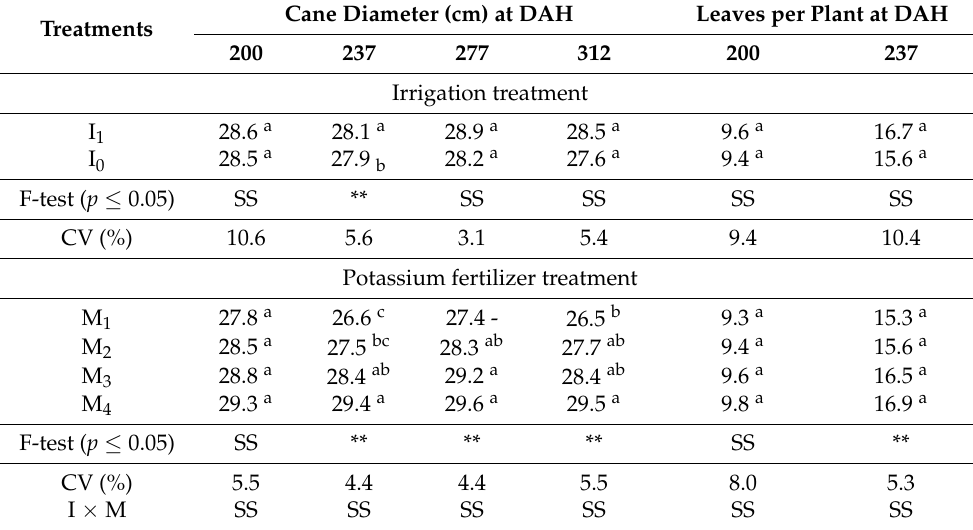
Table 2. Average sugarcane diameter and number of leaves under irrigation and potassium treat- ments. Cane Diameter (cm) at DAH Leaves per Plant at DAH Treatments 200 237 277 312